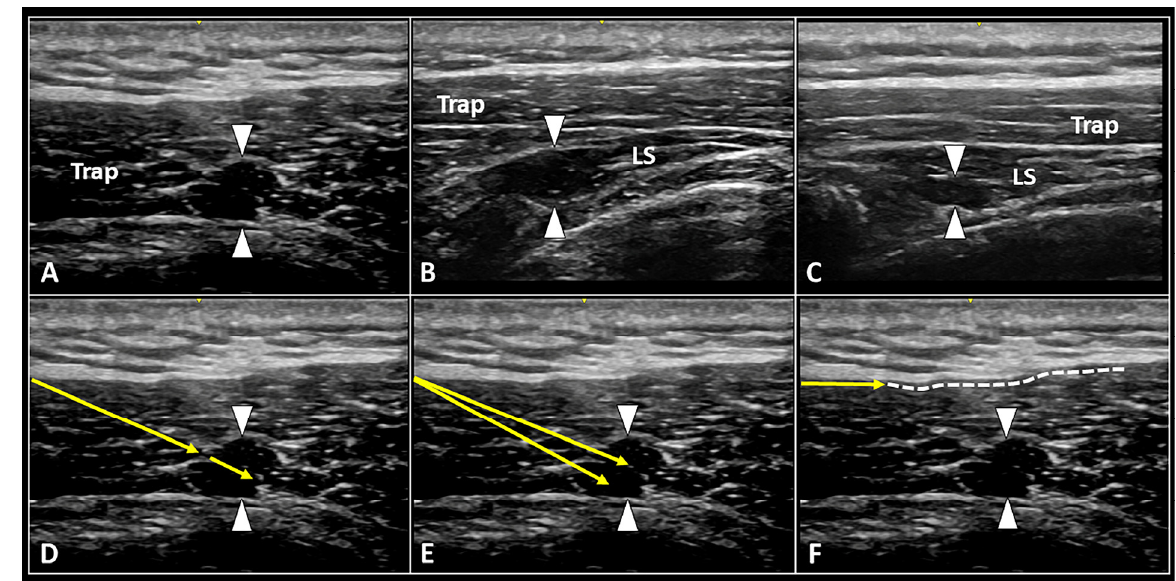
Figure 1. Ultrasound images show MTrPs (white arrowheads) at the level of cervical spine located both within superficial muscles ( A ), e.g., upper fibers of trapezius (Trap), and deeper muscle planes ( B , C ), e.g., the levator scapulae (LS). Under real-time US guidance, back-and-forward movements of the needle (yellow arrow) to ‘release’ the nodule ( D ), fan-like dry needling of the trigger point ( E ), and hydro-dissection ( F ) of the histological interface between the muscle and the deep fascia (white dotted line) can be performed in a single multi-step procedure.